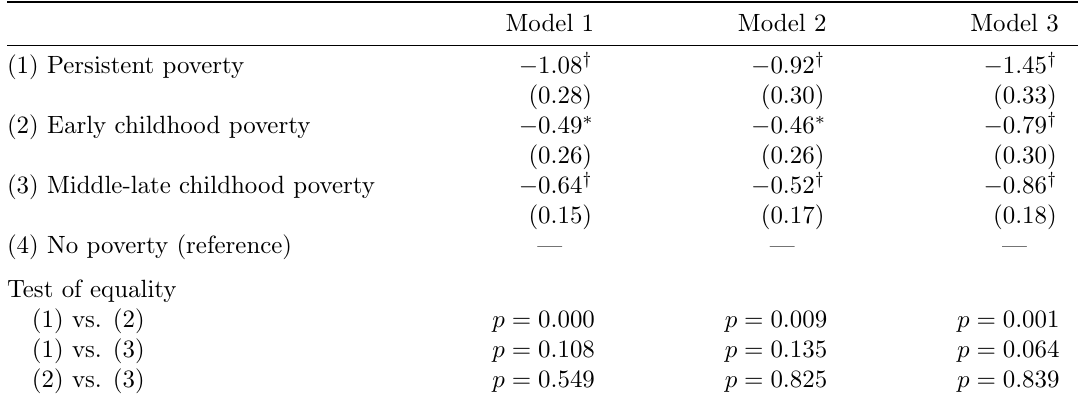
Table 4: Effect of Poverty Trajectories on High School